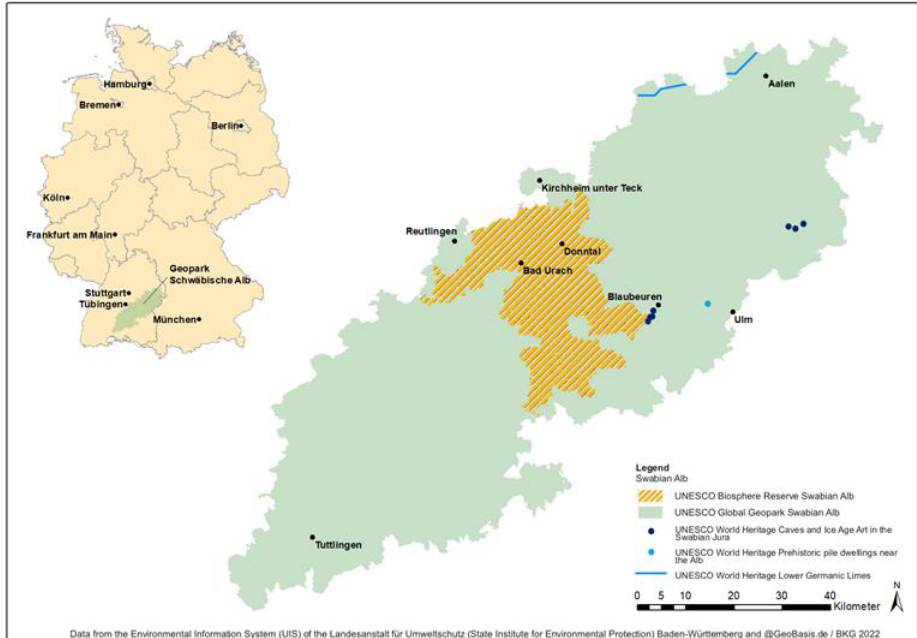
Figure 5. UGGp Swabian Alb and UNESCO designations (Author’s design based on UGGp Swabian Alb).